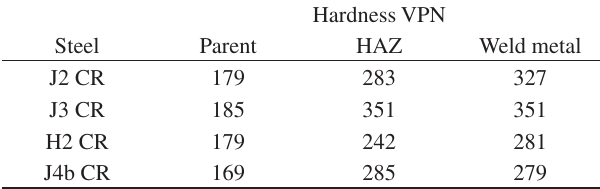
Table 3. Maximum hardness values recorded from the bead-on-plate weld- ability test specimens.